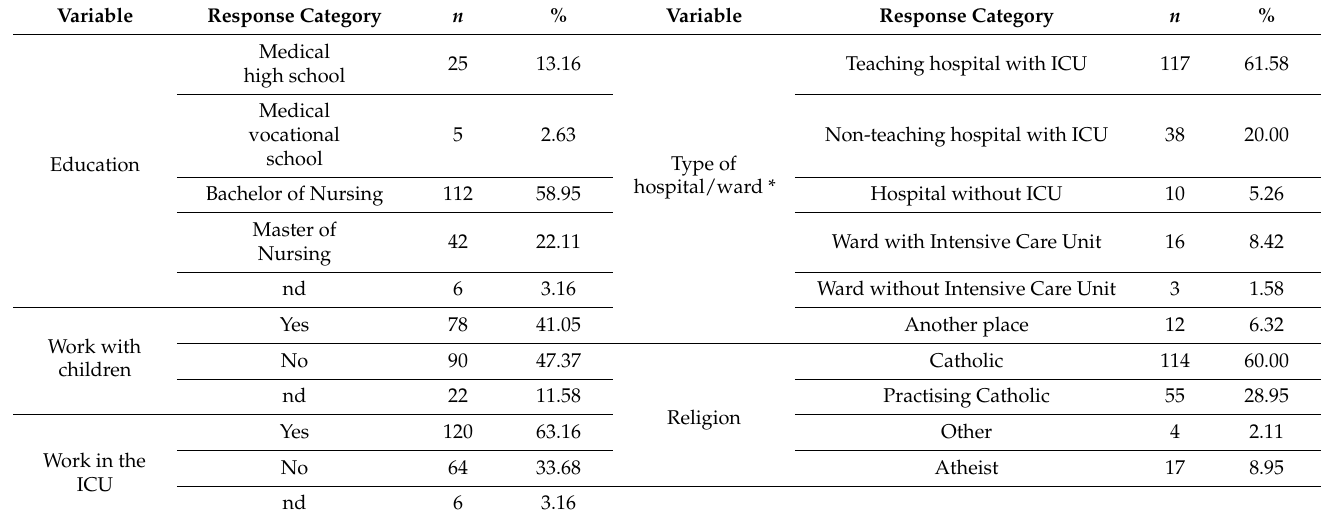
Table 1. General characteristics of the studied population, including basic qualitative